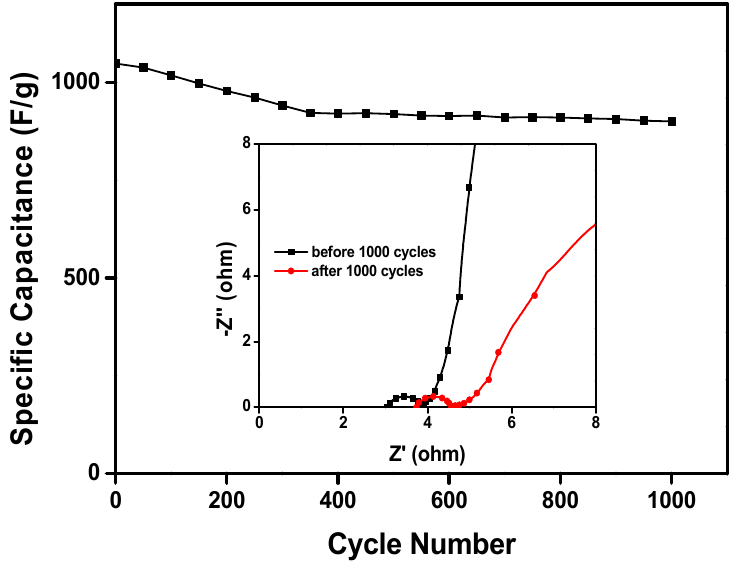
Figure 11. The retention of capacitance after charge–discharge 1000 cycles and the impedance changes.